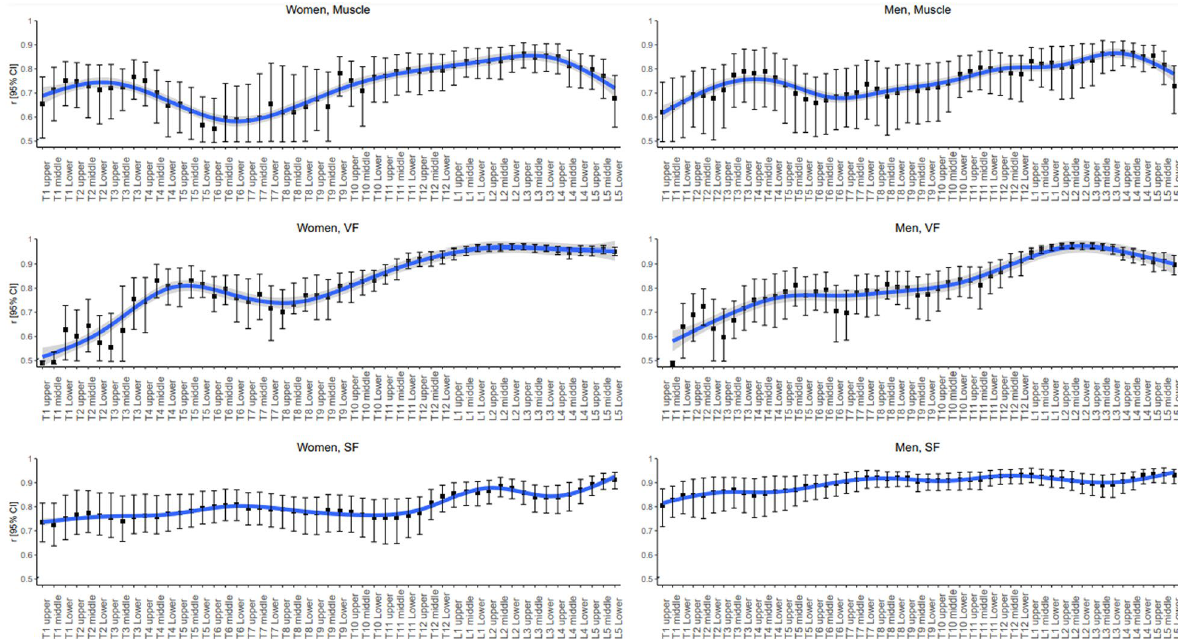
Fig. 4 Bar graphs of Pearson correlation coefficients for whole‑body composition and 95% confidence intervals based on 1000 bootstrap